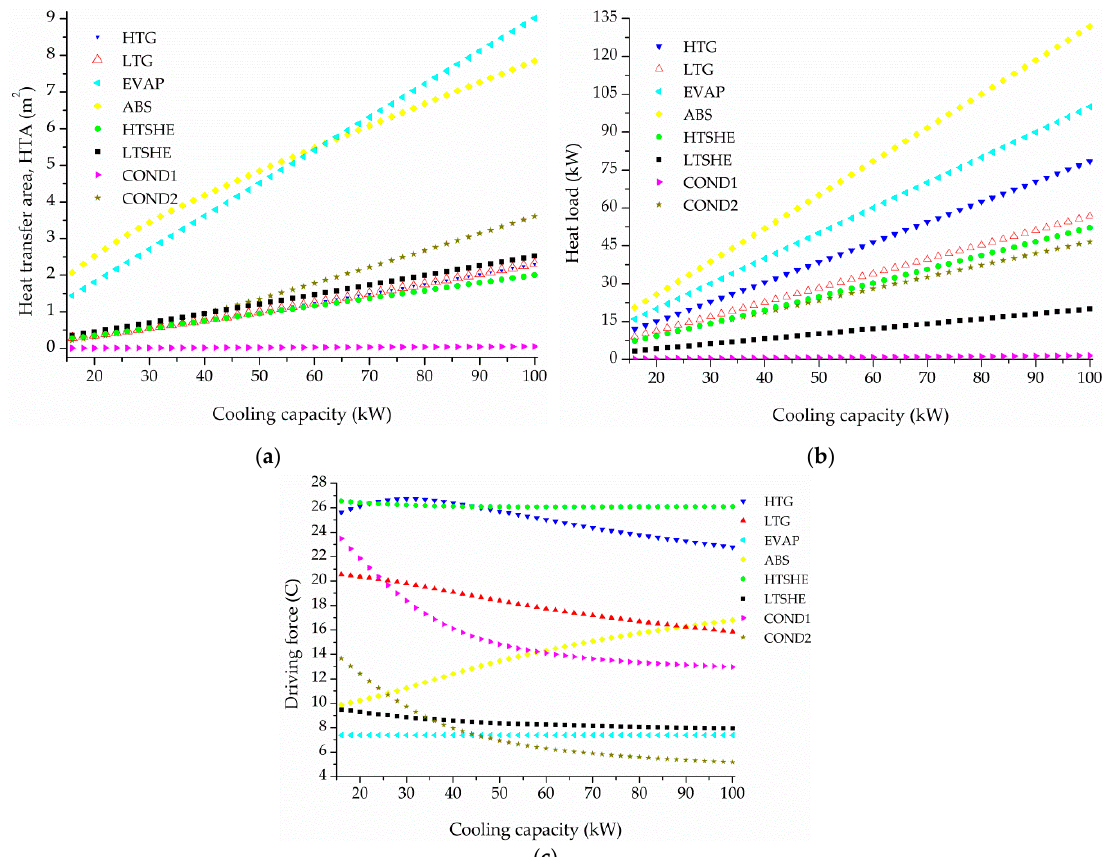
Figure 4. Optimal values for each process unit of ( a ) heat transfer area; ( b ) heat loads; ( c ) driving force, versus the cooling capacity